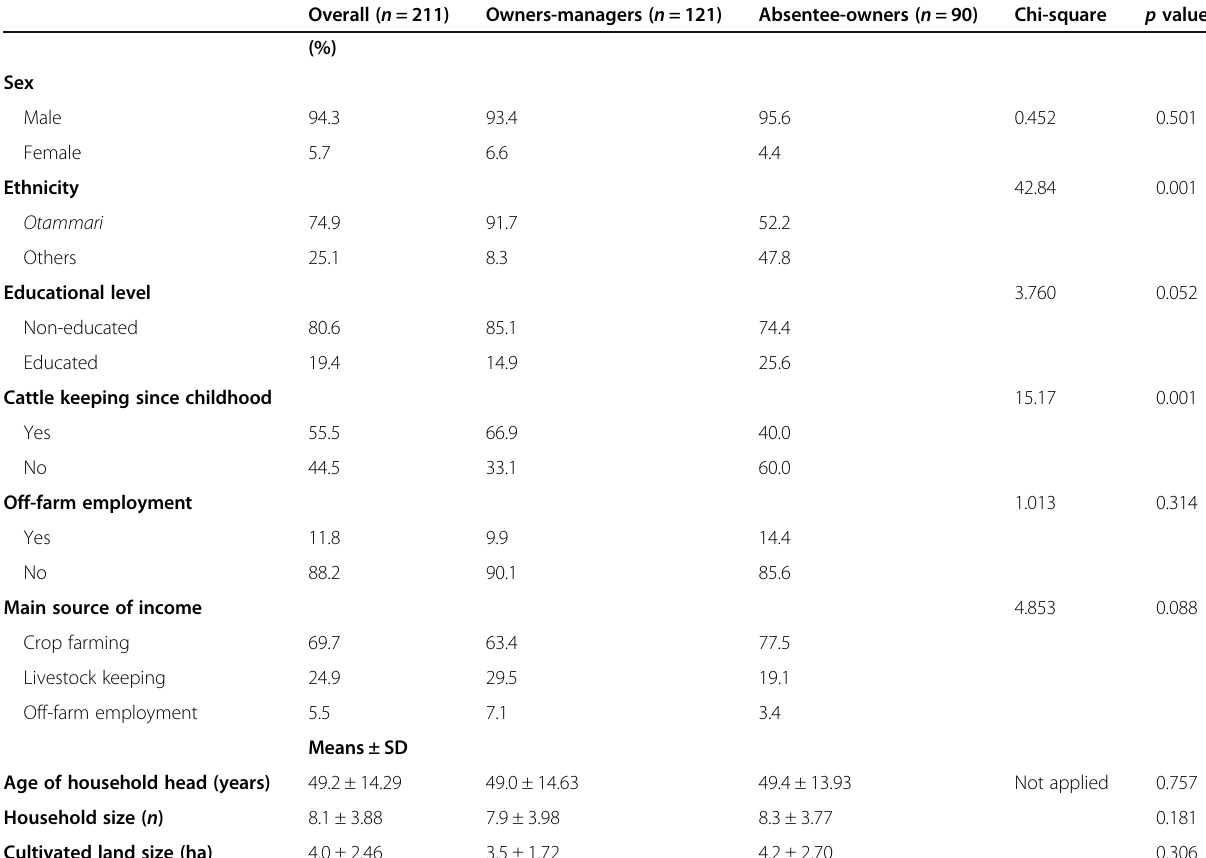
Table 2 Socio-economic characteristics of cattle owners-managers and absentee-owners Overall ( n =